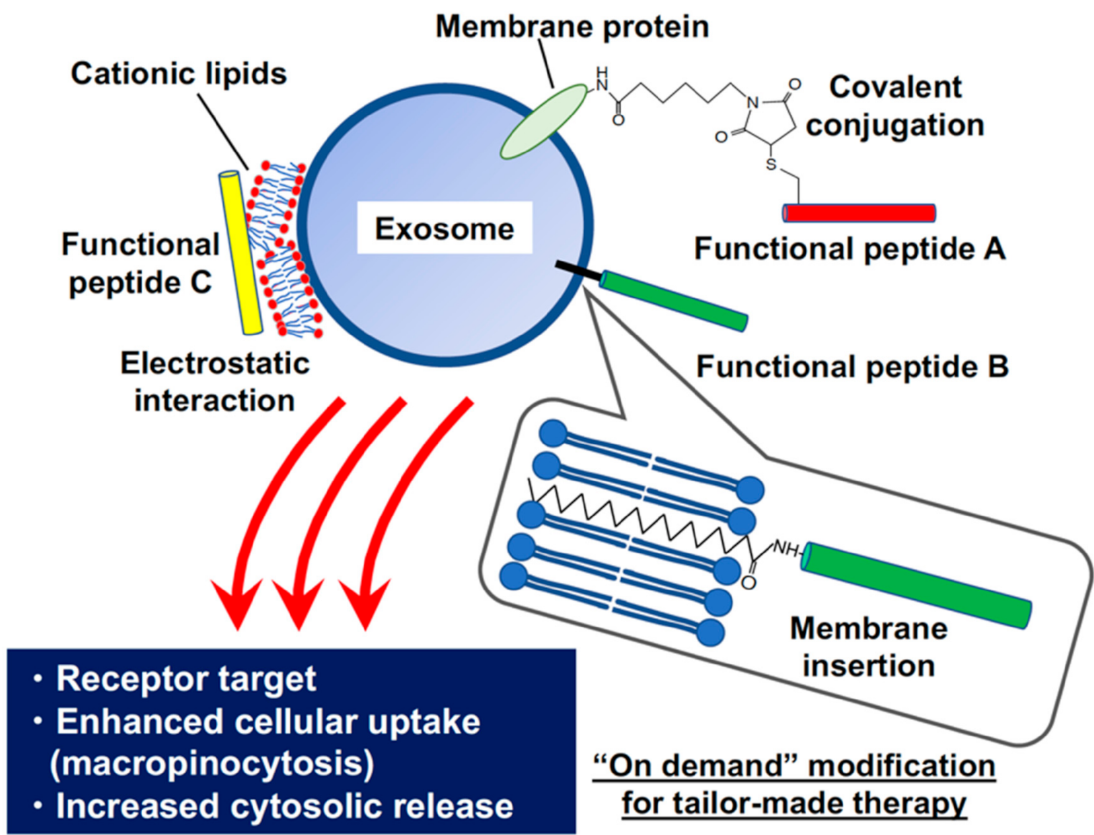
Figure 1. Modification of biofunctional peptides on exosomal membranes to target recipient cellular membrane proteins and enhance the cytosolic release of exosome